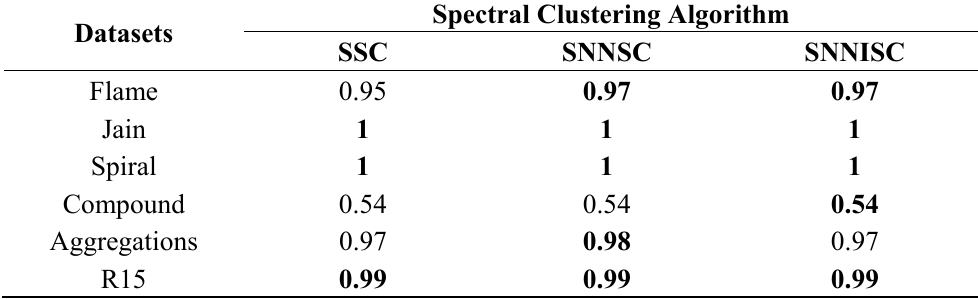
Table 3. The results of adjusted Rand index (ARI) on synthetic datasets. SSC, self-tuning spectral clustering; SNNSC, spectral clustering based on shared nearest neighbors, SNNISC, nearest neighbors.